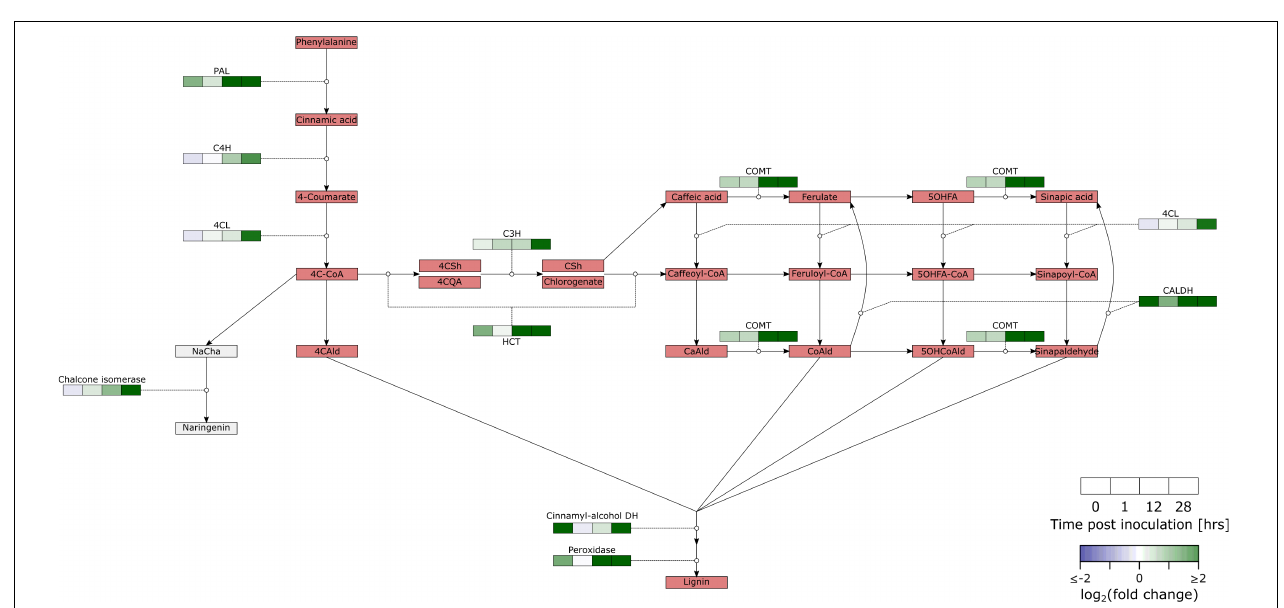
Frontiers in Microbiology |